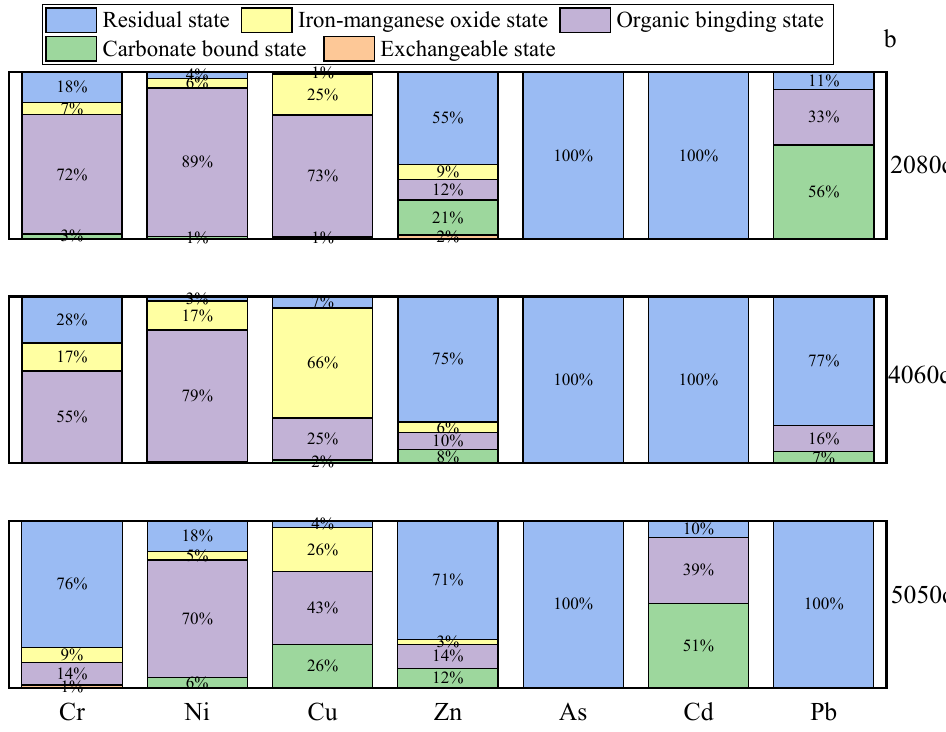
Figure 5. HM distribution patterns in ( a ) glass and ( b ) glass ceramic samples.